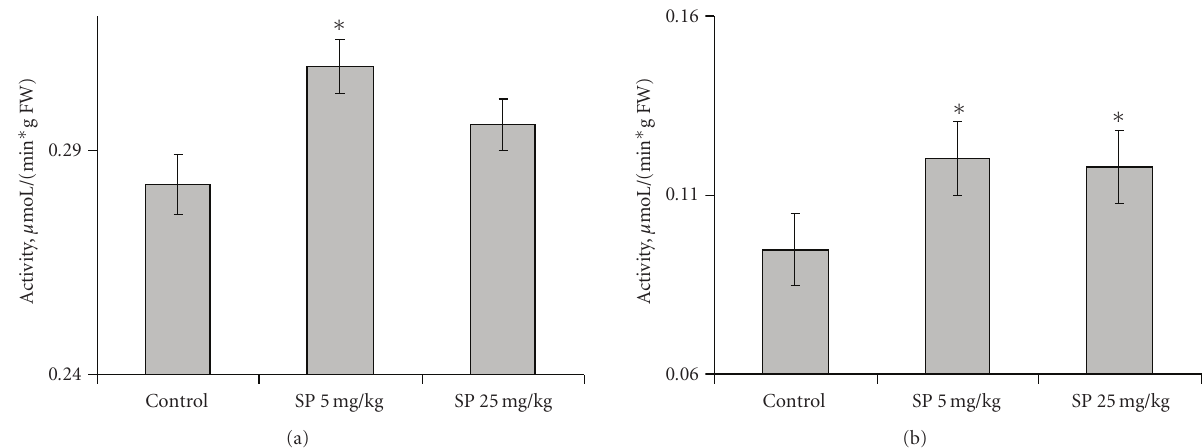
Figure 3: Influence of the SP treatment (5 and 25mg/kg) on the cortex (a) and striatum (b) activity of OGDHC in male rats. Statistical significance: ∗ P < . 05 .